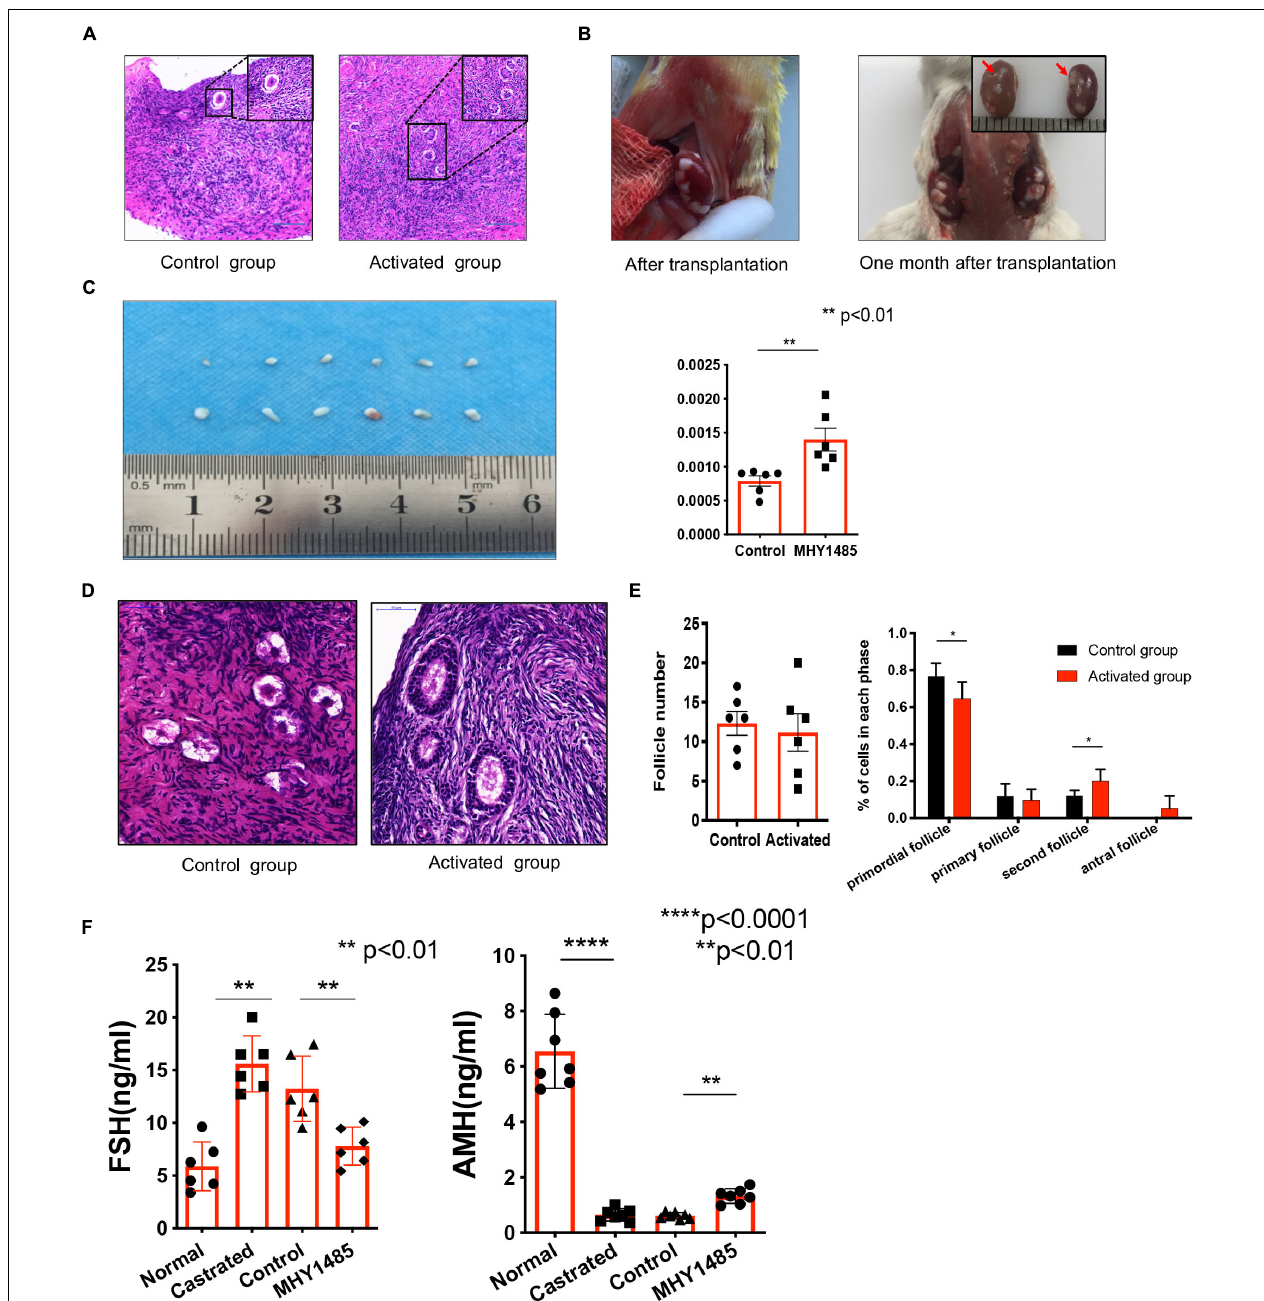
FIGURE 2 | Treatment of MHY1485 can effectively promote human follicle growth and restore endocrine functions. Human ovarian fragments were cultured with 10 µ M MHY1485-added media (activated group) or culture media only (control group) in vitro . Histological analyses showed that there was no obvious necrosis or morphological change when the two groups were compared. (A) Control group treated without MYH1485, Bars: 100 µ m. Activated group treated with MYH1485, Bars: 100 µ m. (B) No abnormal histological affected on human ovarian tissues after transplantation. (C) Graft weight changed. After treatment of MHY1485 one month, grafts weight increased compared with the control group. Data was applied paired t test for statistical analysis and presented as the mean ± SEM ** P < 0.01, N = 6. (D) Following histological analyses, the development of larger growing follicles was observed in the MYH1485-treated ovarian tissues, Bars: 50 µ m. Whereas primary follicles remained dormant in the untreated ovarian tissues, Bars: 50 µ m. (E) Follicle counting results ( right: total follicle numbers per fragment; left: follicle dynamics), showed that the number of growing follicles increased after activation with 1 month. Data was applied paired t test for statistical analysis and presented as the mean ± SEM * P < 0.05, N = 6. (F) FSH (ng/ml) elevated after the surgical castration of the SCID mice and decreased 1 month after activated grafts were transplanted into host mice, ** P < 0.01, N = 6. AMH (ng/ml) dropped after surgical castration and slightly increased 1 month after activation (normal:untreatment; castrated:after castrated without other treatment; control:castrated with normal medium treatment; MHY1485: castrated with MHY1485 medium treatment). Data was applied ANOVA for statistical analysis and presented as the mean ± SEM ** P < 0.01, **** P < 0.0001, N = 6.